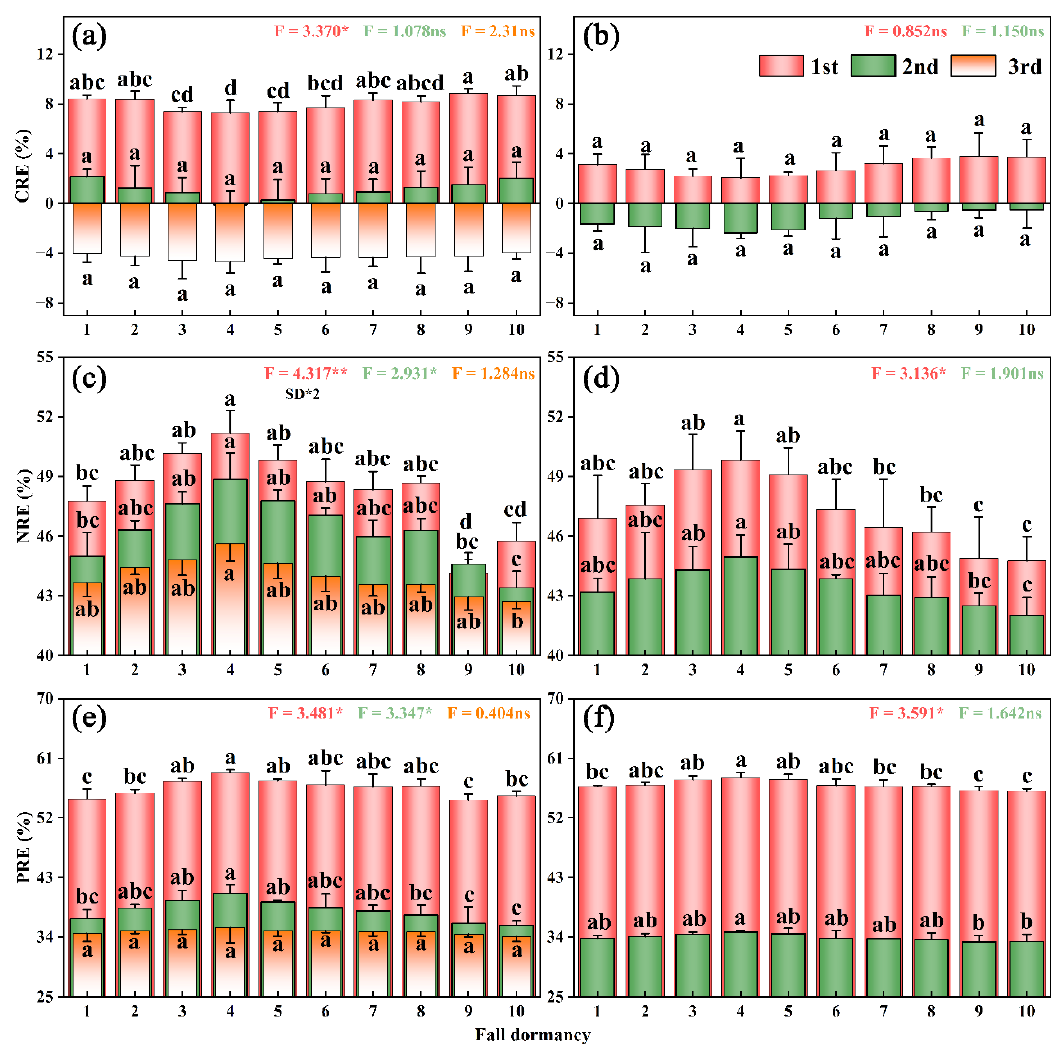
Figure 6. Nutrient reabsorption efficiency of alfalfa with different fall-dormancy levels, where ( a , c , e ) are 2020 test data, and ( b , d , f ) are 2021 test data. Different small letters indicate significant differences between different fall dormancy levels ( p < 0.05). ns indicates no significant difference between different fall dormancy levels ( p > 0.05), * indicates significant difference between different fall dormancy levels ( p < 0.05) and ** indicates extremely significant difference between different fall dormancy levels ( p < 0.01).